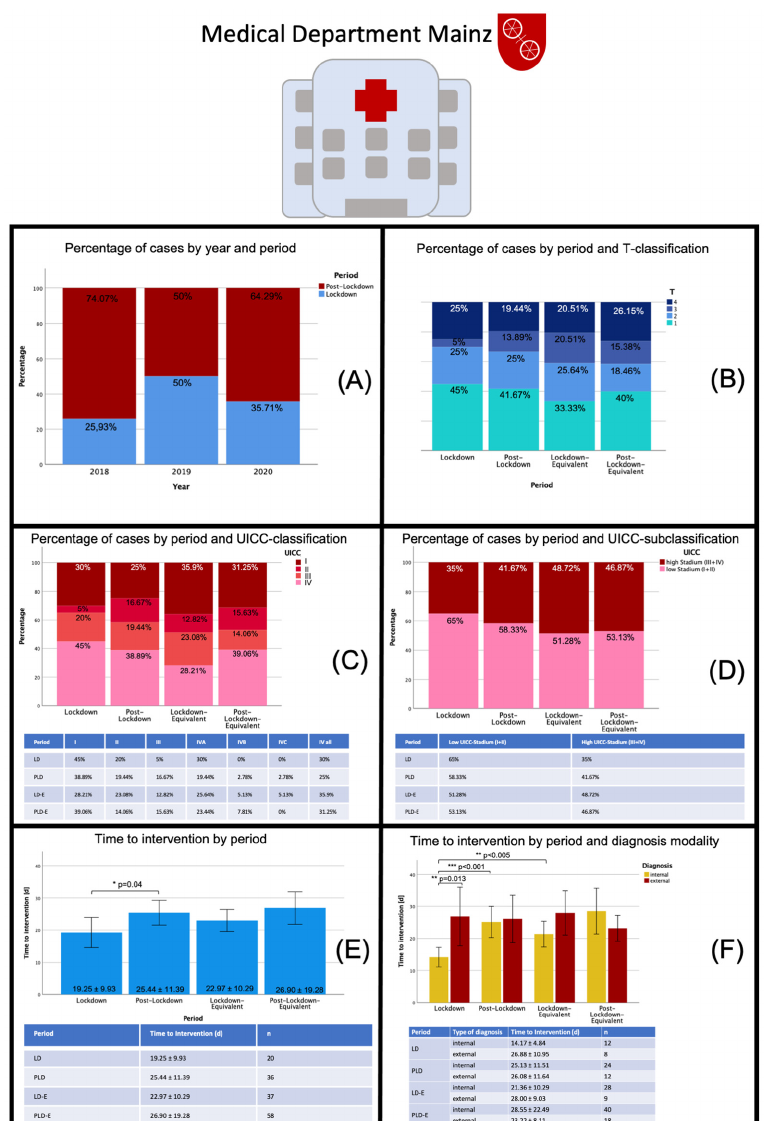
Figure 2. Data sheet Medical Department Mainz: Distribution of patients with oral malignant lesions by different periods, distribution of tumor stages (T-classification, UICC-classification) and time to intervention during the different periods. Abbreviations: LD—lockdown; PLD—post-lockdown; LD-E—lockdown equivalent; PLD-E—post-lockdown equivalent; UICC—Union international contre le cancer. In ( A ) cancer diagnoses per year and period are displayed (in percent) show-